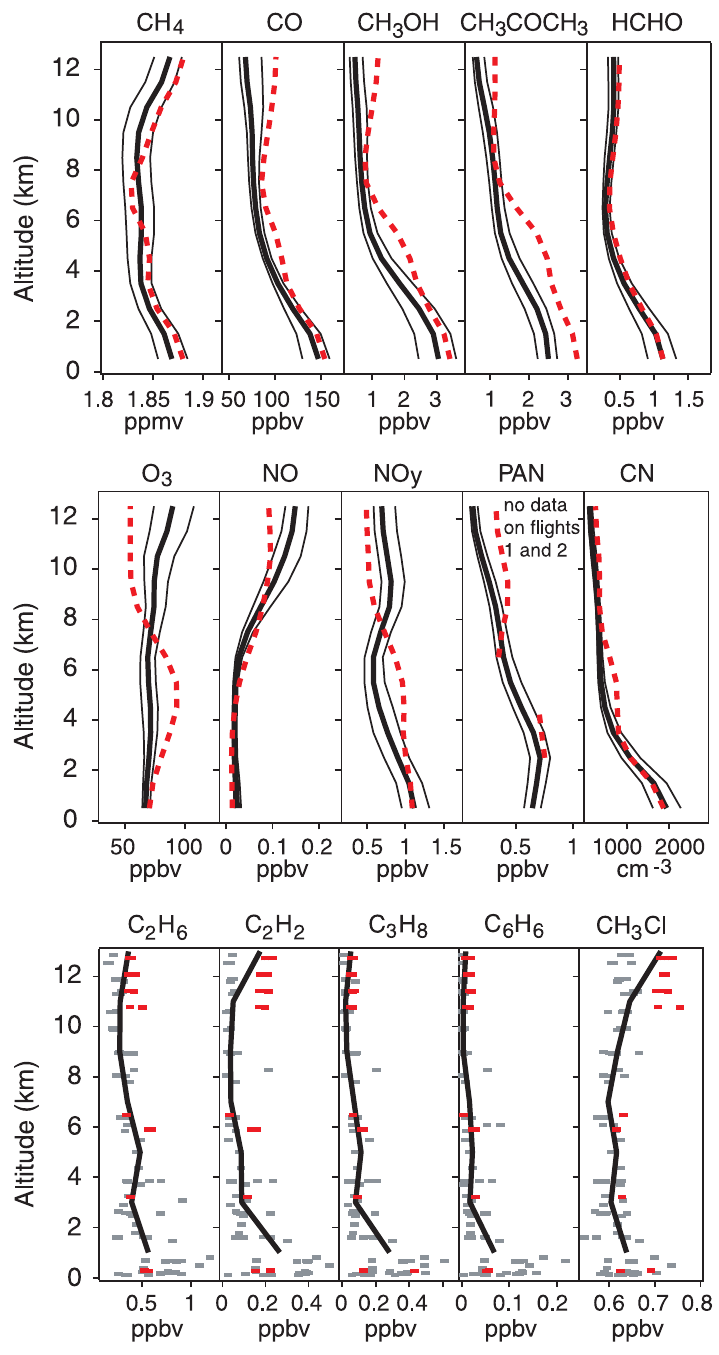
Fig. 2. ( Left ) Median vertical profiles (thick black lines), 1 (cid:3) standard Fig. 47. Vertical profiles of trace gases measured during the 14 MINOS flights in August 2001. Thick solid lines are median values, thin solid lines are ± 1 σ , dashed lines are the median values for only the first three flights (which sampled the Asian summer monsoon plume), deviations (thin black lines), and actual concentrations from canis- and small boxes (bottom row) are individual canister samples (from Lelieveld et al., 2002, copyright 2002 by the American Association for ter samples (squares) obtained from 14 measurement flights in the Advancement of Science, reproduced with August 2001. The red dashed lines and squares present median and actual values, respectively, for the first three flights on 1, 3, and 8 August. During this week, the pollution from eastern Europe (lower 4 km), western Europe (4 to 6 km) and the southern Asian monsoon ( (cid:1) 8 km) was particularly strong. ppmv, parts per million by volume. Fig. 3. ( Right ) CO tracer simulations, representing the western and eastern Mediterranean (left and right columns, respectively) during August 2001. The top panels show total CO; the other panels show fractional contributions from emissions in eastern Europe ( (cid:1) 15°E), western Europe ( (cid:4) 15°E), North America, and Asia.